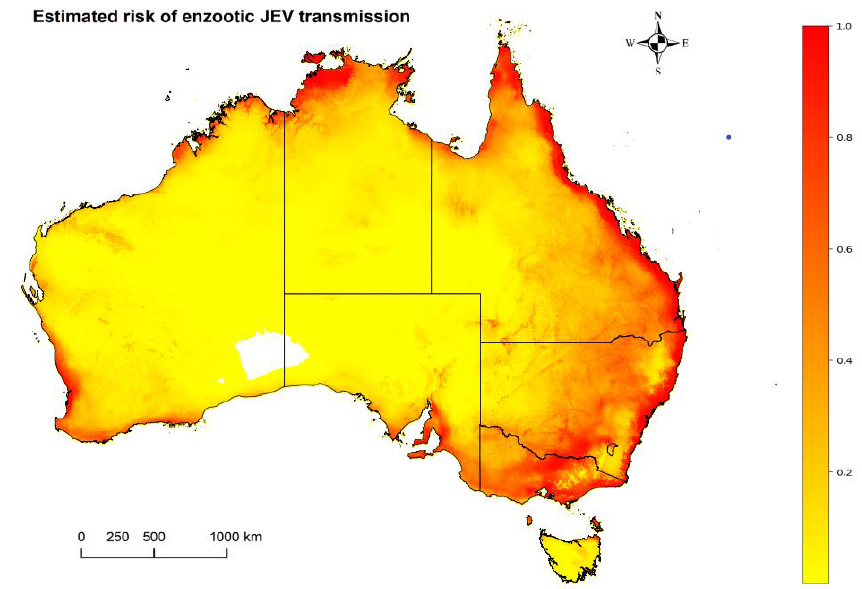
Figure 4. The estimated enzootic risk of JEV transmission in Australia where the estimated risk ranges from zero (white) and low (yellow) to high (red). This shows a combination of free roaming wild species (water birds OR feral pigs) AND the vector presence.